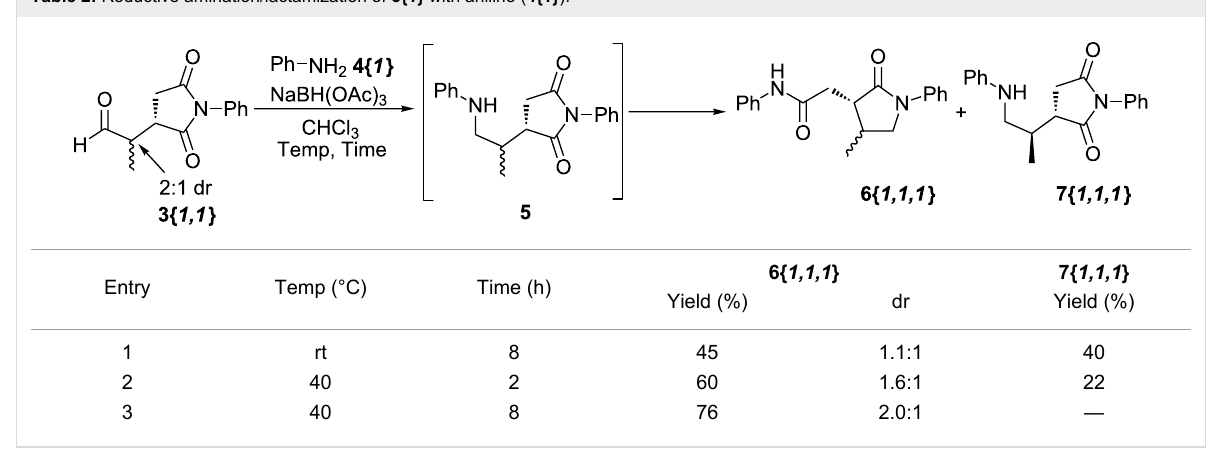
Table 2: Reductive amination/lactamization of 3{ 1 } with aniline ( 4{ 1 }